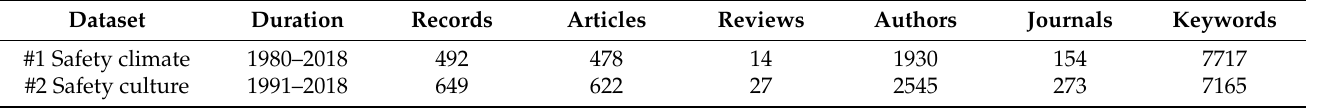
Table 1. Brief statistics of the datasets.